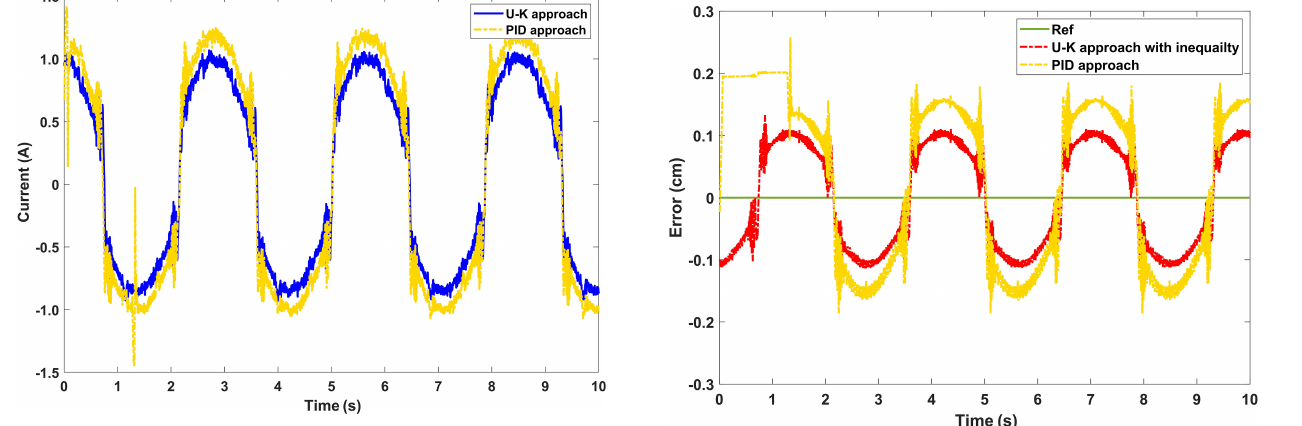
Figure 17. The experimental error of the steady-state performance of the U–K inequality constraint and